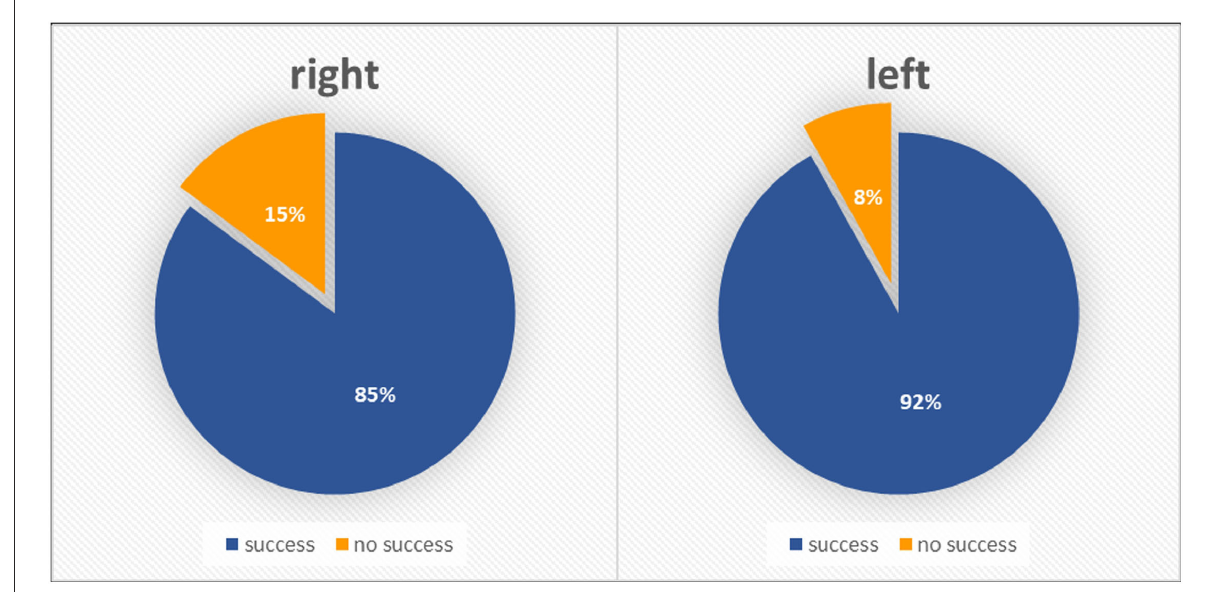
FIGURE3 Severe aortic stenosis population–radial approach success rates according to initial side